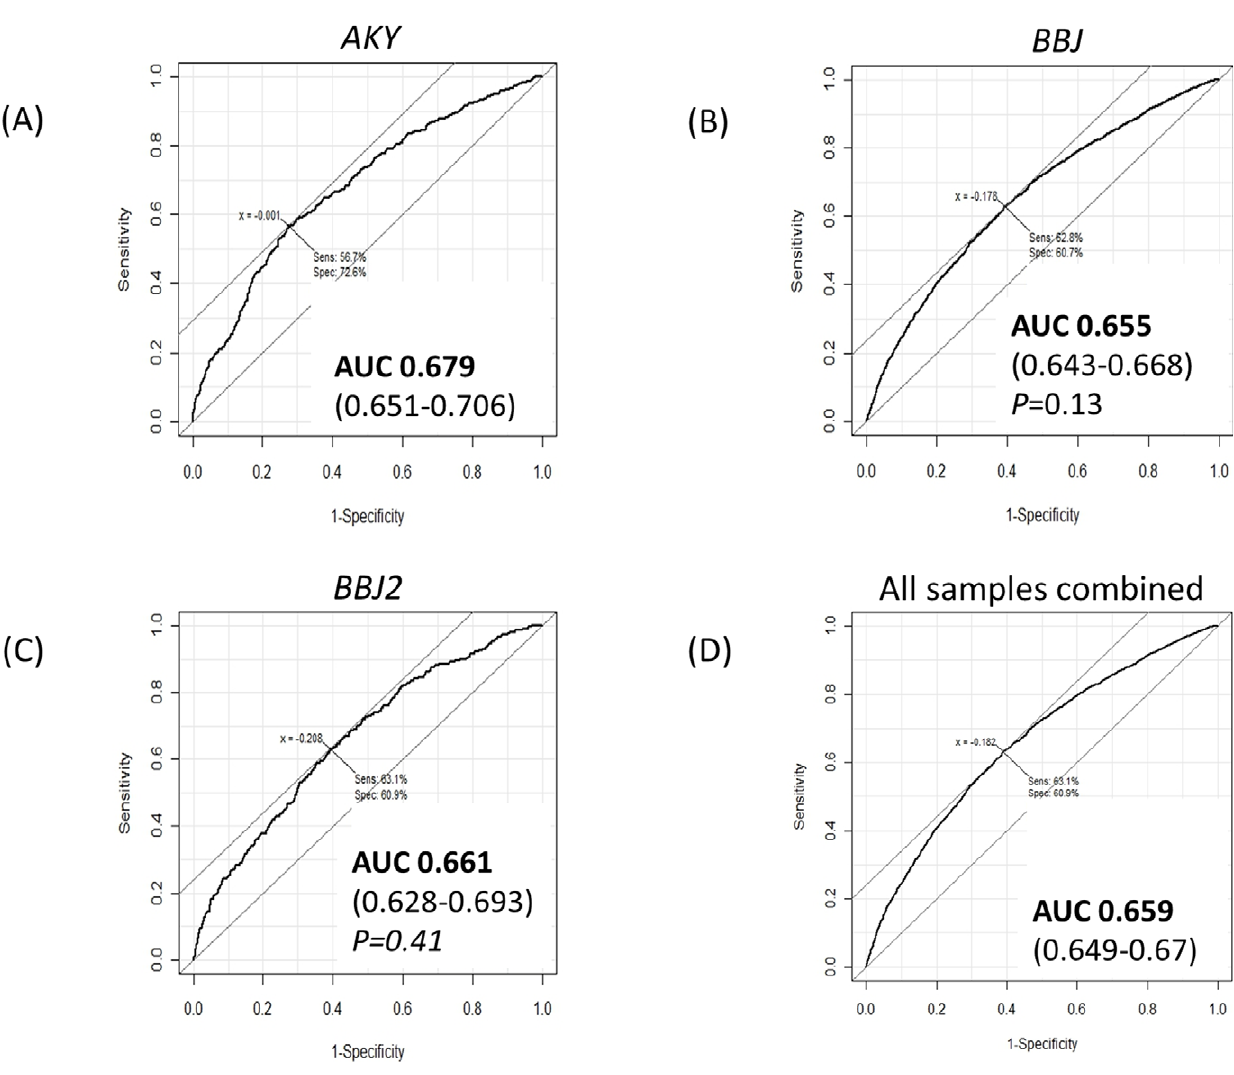
Figure 1. ROC curves for (A) the samples used to create the genetic risk prediction model ( AKY ), (B)(C) the two validation studies ( BBJ and BBJ2 ), and (D) when all the samples were combined. The AUCs of the model and 95% confidence intervals are indicated. The AUCs of BBJ and BBJ2 are statistically compared with that of AKY , and P -values are reported. (x: the logarithm of odds ratio at the best cut off, Sens: sensitivity of the model at the best cutoff, Spec: specificity of the model at the best